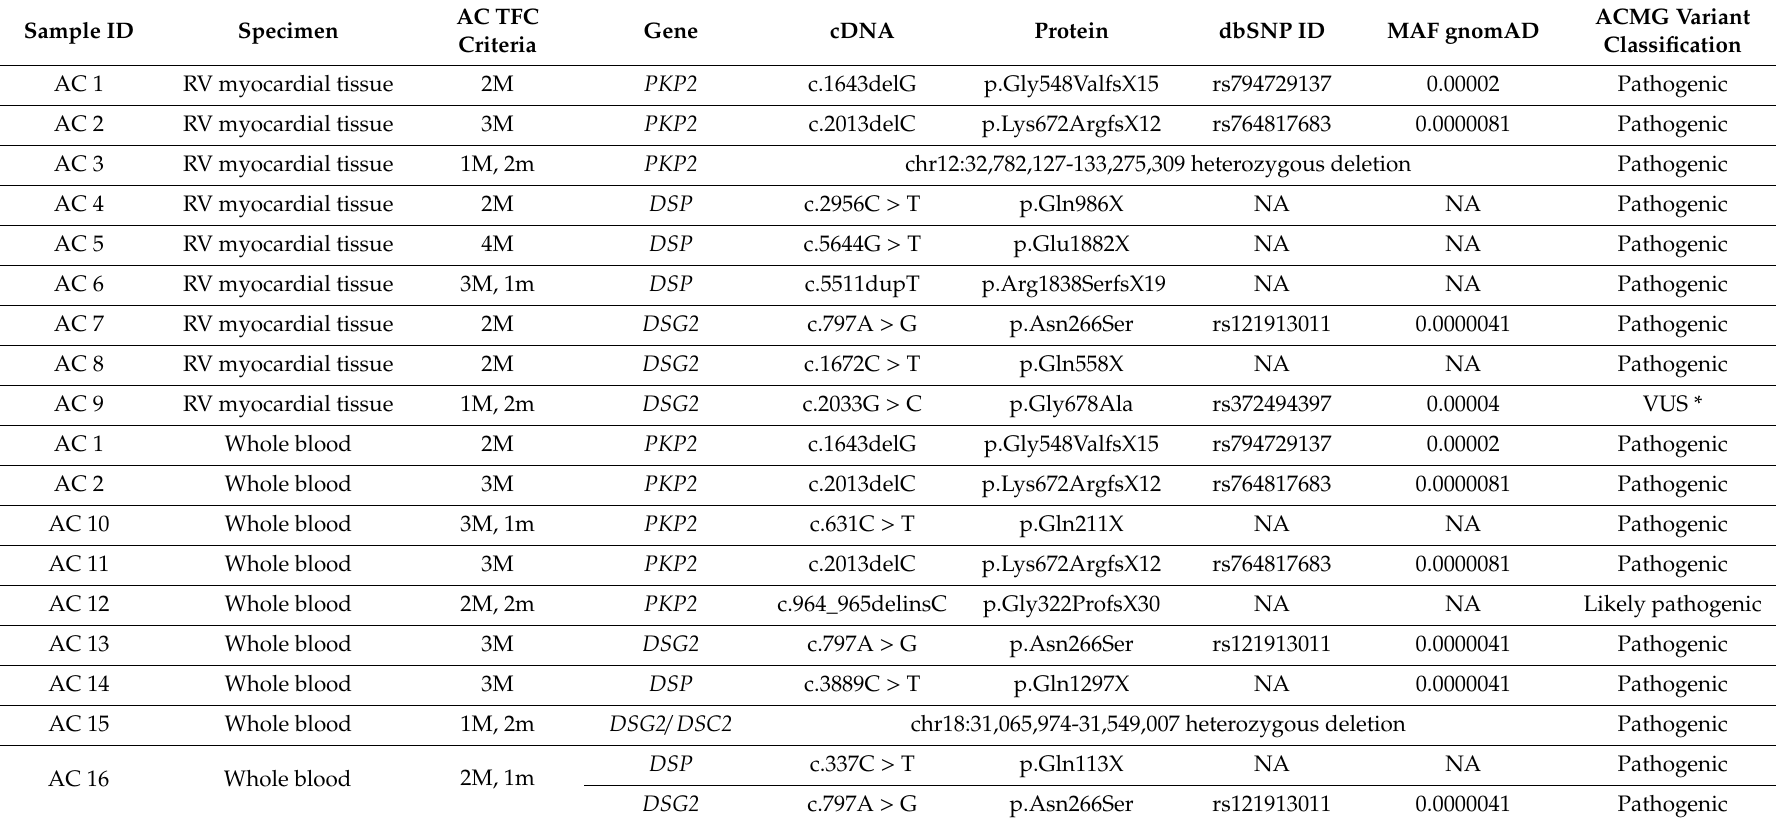
Table 1. Discovery cohort: genetics and clinical